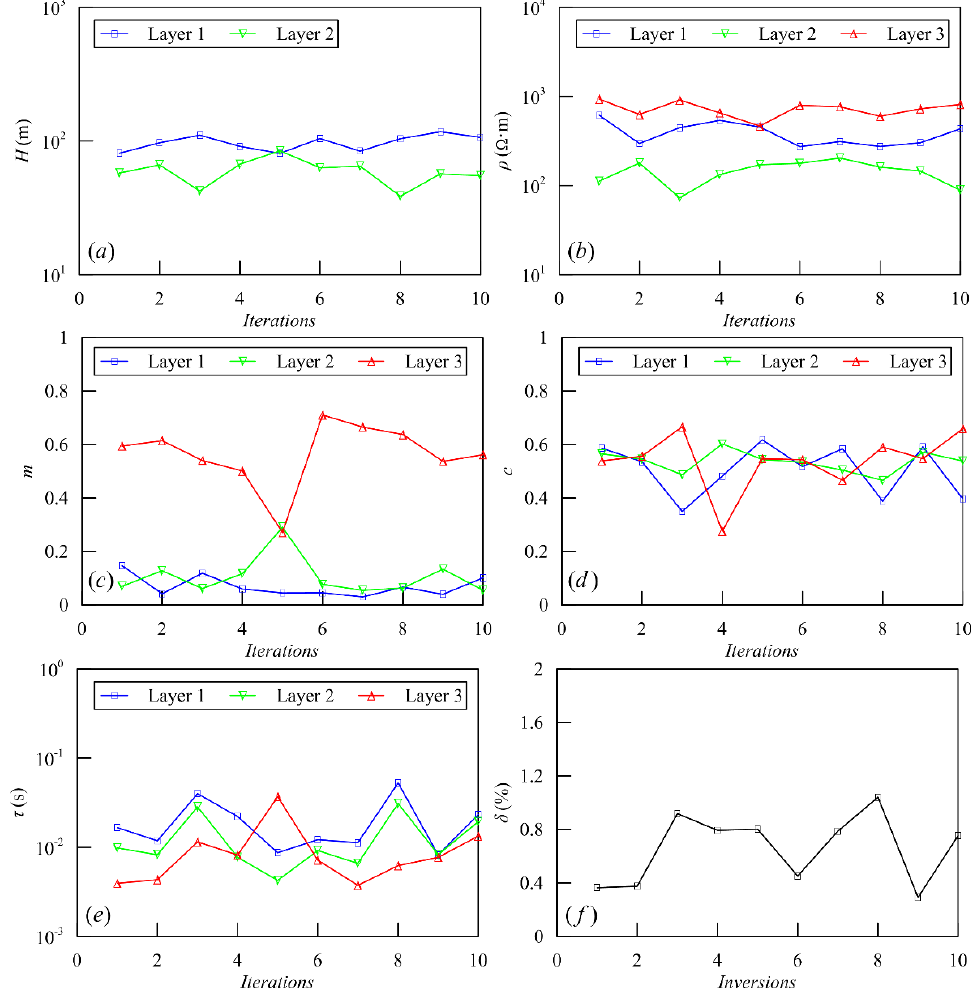
Figure 5. The inversion parameters of Model 3 using single source. ( a ) The layer thickness; ( b ) The resistivity; ( c ) The chargeability; ( d ) The frequency exponent; ( e ) The time constant; ( f ) The relative fitting error.